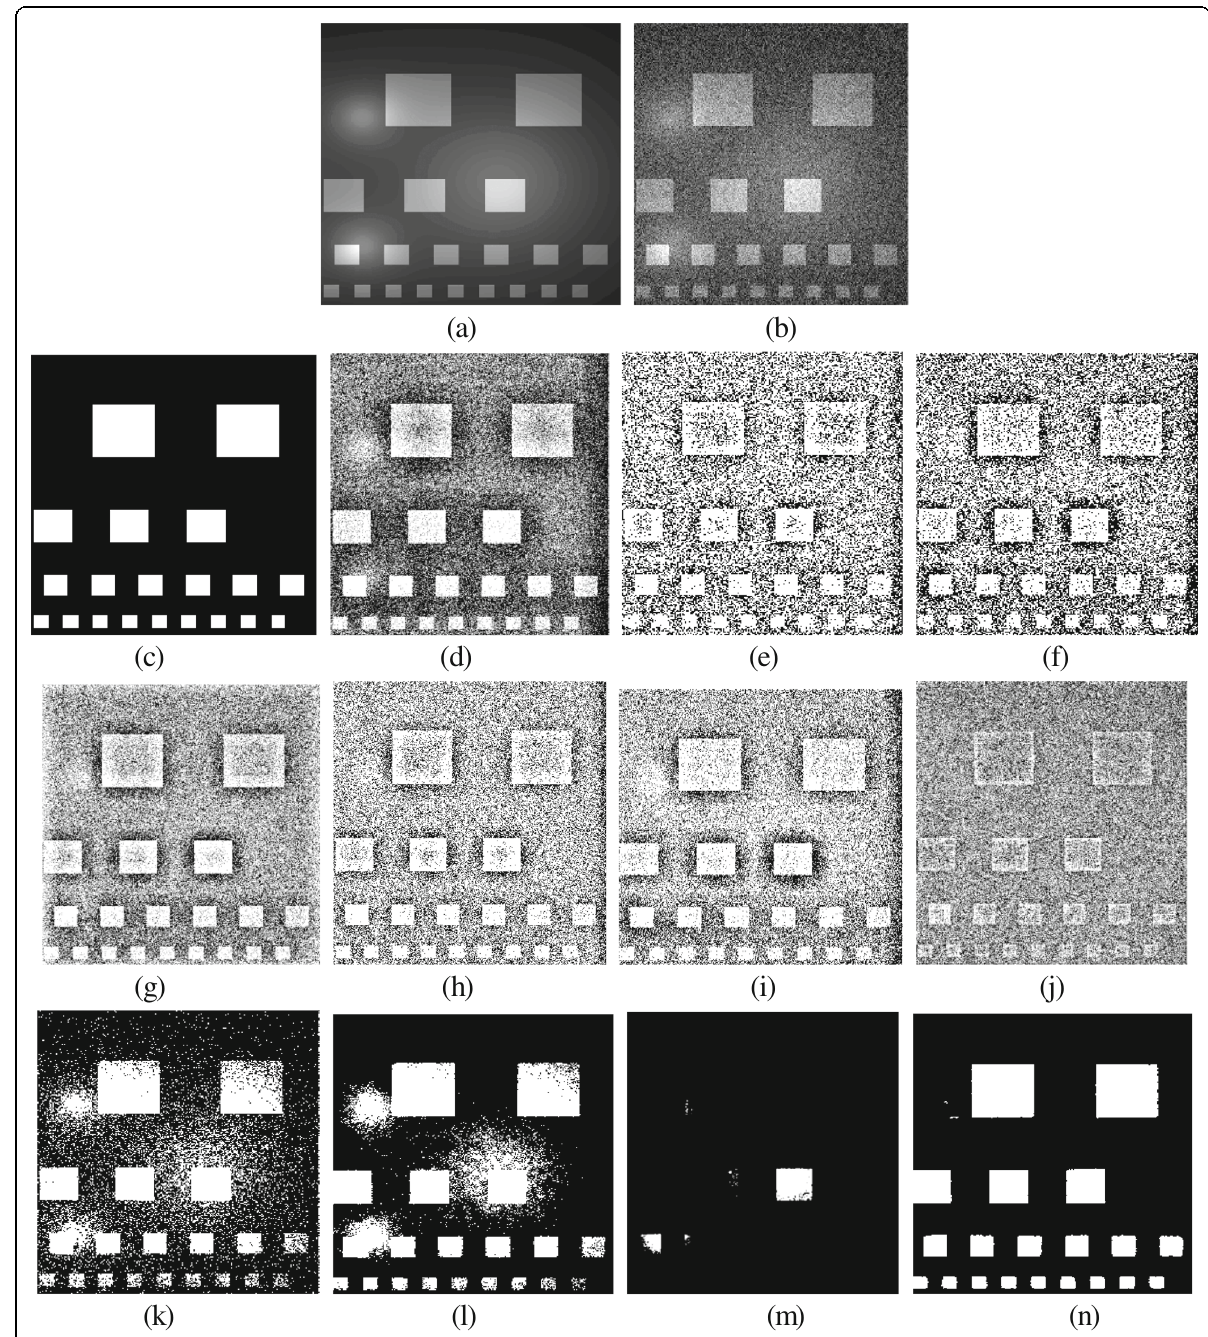
Fig. 11 Segmentation results on the block image 511 × 441 corrupted by the Gaussian noise (0, 0.015). a Original image. b Noisy image. c Ground-truth. d Bernsen ’ s method. e Niblack ’ s method. f Sauvola ’ s method. g Bradley ’ s method. h Chou ’ s method. i Valizadeh ’ s method. j Wei ’ s method, k 2DOtsu. l FCM_NLS. m 2DWFPE. n Our method with T = 800, α =